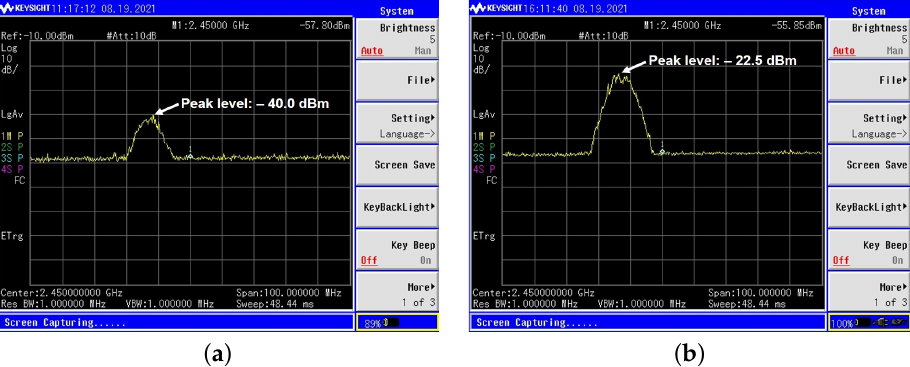
Figure 10. Spectrum analyzer of the experiment environment. ( a ) Spectrum image of 802.11 b at 3 m. ( b ) Spectrum image of 802.11 b at 18